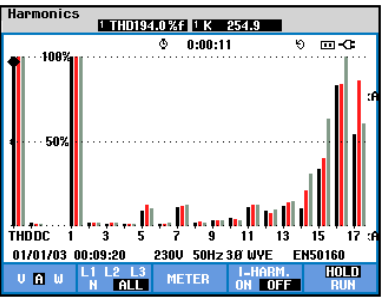
Figure 25. Waveforms of capacitor current.